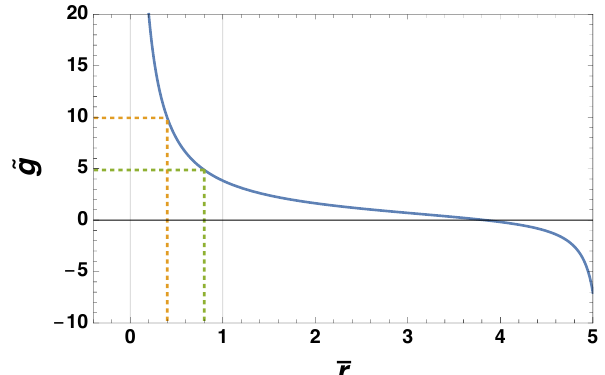
Figure 2. Plot of the function ˜ g ( ¯ r ) of Equation (46),as a function of ¯ r . The dashed lines correspond to the region A : ¯ r 0 < ¯ r < ¯ r 1